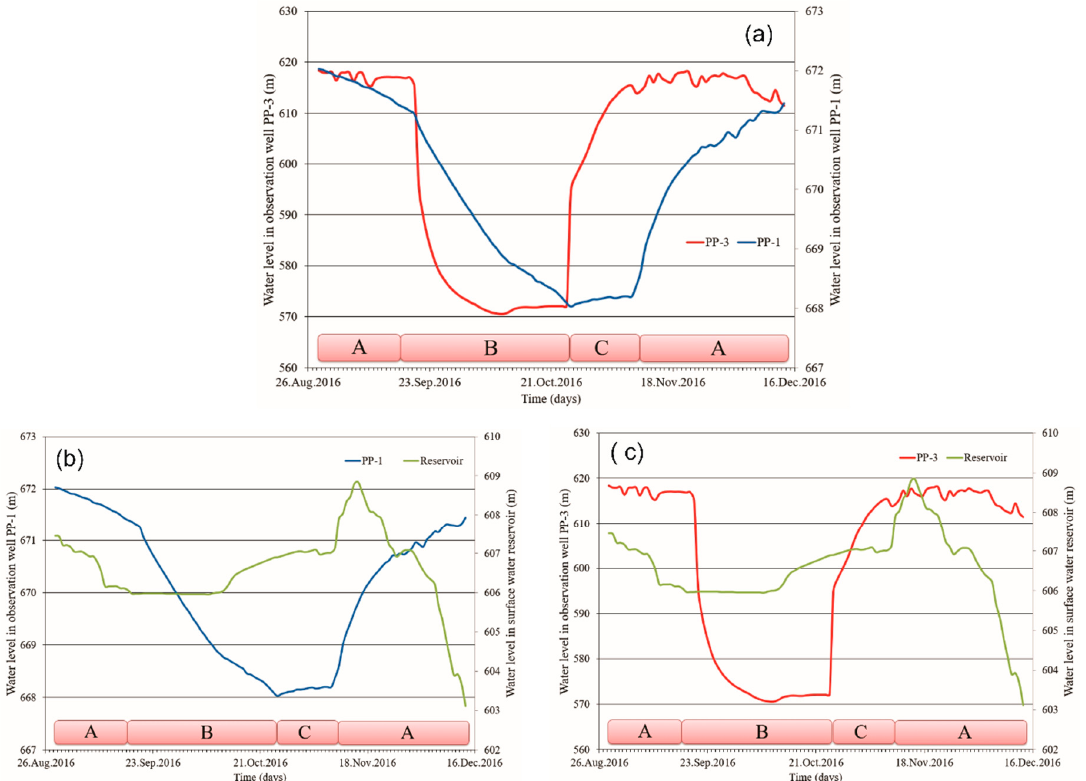
Figure 3. ( a ) Comparative plots of groundwater levels in observation wells PP-1 and PP-3, ( b ) Comparative plots of groundwater levels in observation well PP-1 and the water level in surface water reservoir, ( c ) Comparative plots of groundwater levels in observation well PP-3 and the water level in surface water reservoir, by phase (A, B and C).